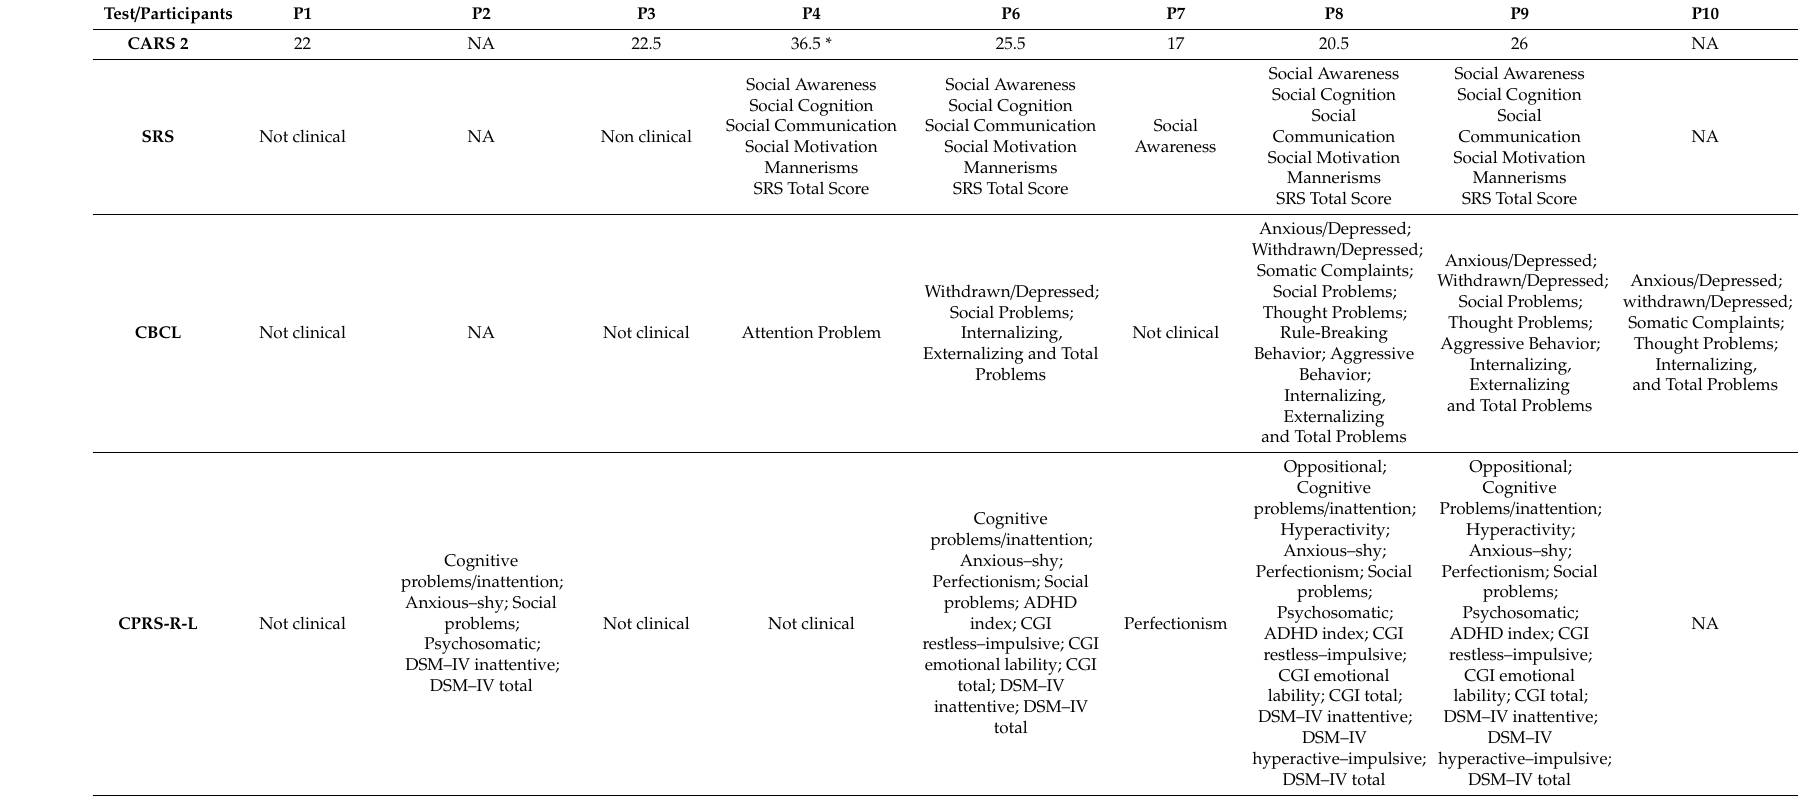
Table 3. Autism symptoms, behavioral and psychopathological